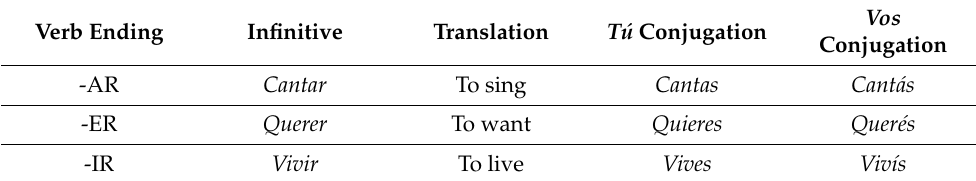
Table 2. T ú versus vos conjugations in the present